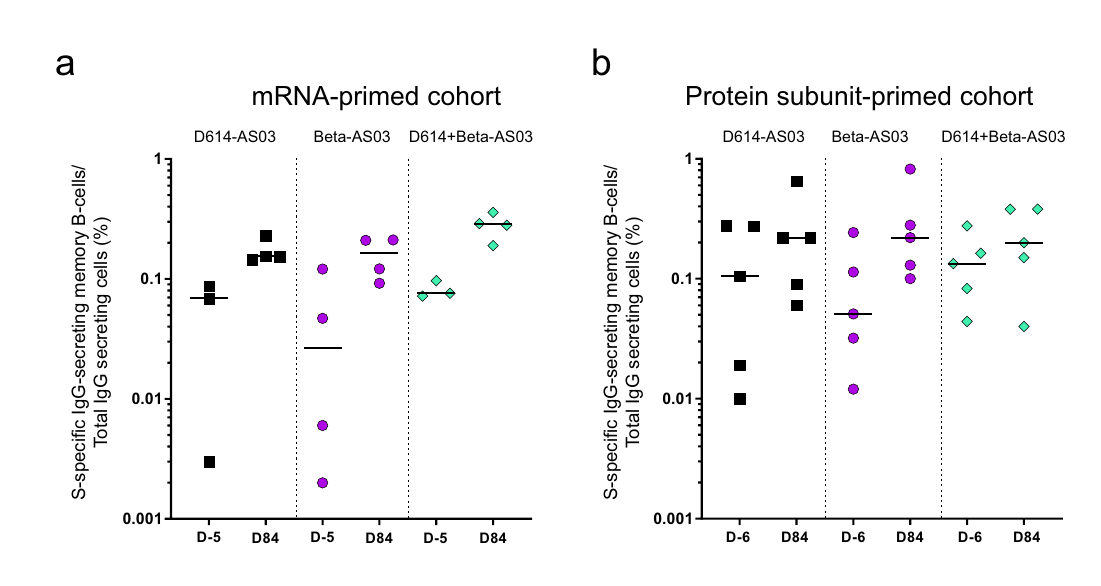
Fig. 4 | Spike-speci fi c IgG memory B cell ELISpot responses in PBMCs from immunized macaques. Spike-speci fi c memory B cell ELISpot results before booster (5 or 6 days before) and at day 84 following booster with ancestral